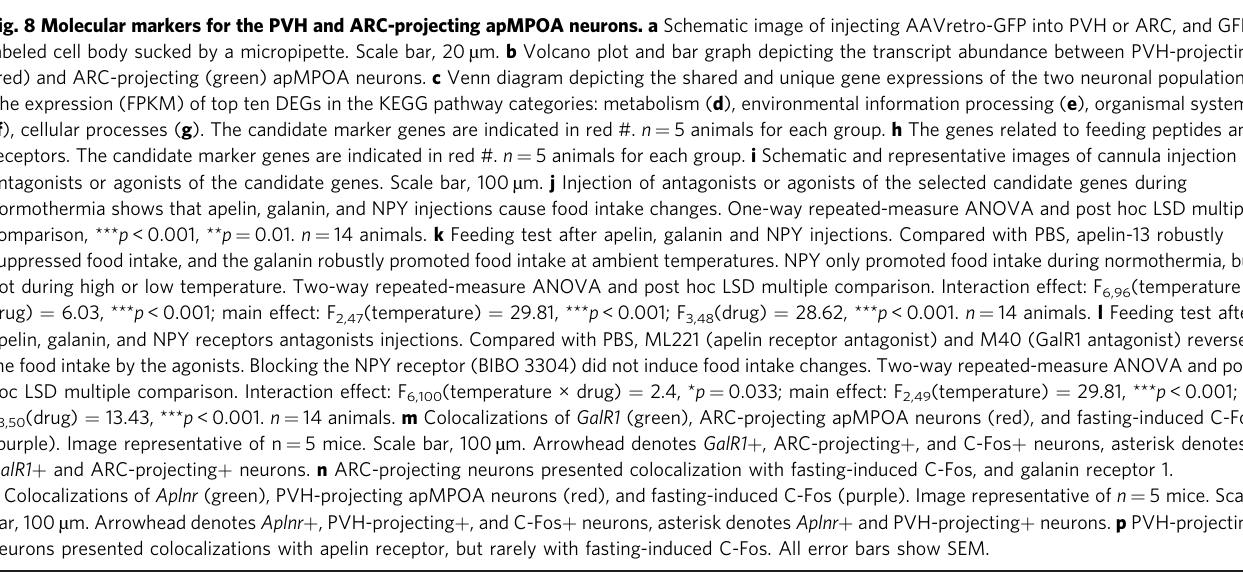
Fig. 8 Molecular markers for the PVH and ARC-projecting apMPOA neurons. a Schematic image of injecting AAVretro-GFP into PVH or ARC, and GFP- labeled cell body sucked by a micropipette. Scale bar, 20 µ m. b Volcano plot and bar graph depicting the transcript abundance between PVH-projecting (red) and ARC-projecting (green) apMPOA neurons. c Venn diagram depicting the shared and unique gene expressions of the two neuronal populations. The expression (FPKM) of top ten DEGs in the KEGG pathway categories: metabolism ( d ), environmental information processing ( e ), organismal systems ( f ), cellular processes ( g ). The candidate marker genes are indicated in red #. n = 5 animals for each group. h The genes related to feeding peptides and receptors. The candidate marker genes are indicated in red #. n = 5 animals for each group. i Schematic and representative images of cannula injection of antagonists or agonists of the candidate genes. Scale bar, 100 µ m. j Injection of antagonists or agonists of the selected candidate genes during normothermia shows that apelin, galanin, and NPY injections cause food intake changes. One-way repeated-measure ANOVA and post hoc LSD multiple comparison, *** p < 0.001, ** p = 0.01. n = 14 animals. k Feeding test after apelin, galanin and NPY injections. Compared with PBS, apelin-13 robustly suppressed food intake, and the galanin robustly promoted food intake at ambient temperatures. NPY only promoted food intake during normothermia, but not during high or low temperature. Two-way repeated-measure ANOVA and post hoc LSD multiple comparison. Interaction effect: F 6,96 (temperature × drug) = 6.03, *** p < 0.001; main effect: F 2,47 (temperature) = 29.81, *** p < 0.001; F 3,48 (drug) = 28.62, *** p < 0.001. n = 14 animals. l Feeding test after apelin, galanin, and NPY receptors antagonists injections. Compared with PBS, ML221 (apelin receptor antagonist) and M40 (GalR1 antagonist) reversed the food intake by the agonists. Blocking the NPY receptor (BIBO 3304) did not induce food intake changes. Two-way repeated-measure ANOVA and post hoc LSD multiple comparison. Interaction effect: F 6,100 (temperature × drug) = 2.4, * p = 0.033; main effect: F 2,49 (temperature) = 29.81, *** p < 0.001; F 3,50 (drug) = 13.43, *** p < 0.001. n = 14 animals. m Colocalizations of GalR1 (green), ARC-projecting apMPOA neurons (red), and fasting-induced C-Fos (purple). Image representative of n = 5 mice. Scale bar, 100 µ m. Arrowhead denotes GalR1 + , ARC-projecting + , and C-Fos + neurons, asterisk denotes GalR1 + and ARC-projecting + neurons. n ARC-projecting neurons presented colocalization with fasting-induced C-Fos, and galanin receptor 1. o Colocalizations of Aplnr (green), PVH-projecting apMPOA neurons (red), and fasting-induced C-Fos (purple). Image representative of n = 5 mice. Scale bar, 100 µ m. Arrowhead denotes Aplnr + , PVH-projecting + , and C-Fos + neurons, asterisk denotes Aplnr + and PVH-projecting + neurons. p PVH-projecting neurons presented colocalizations with apelin receptor, but rarely with fasting-induced C-Fos. All error bars